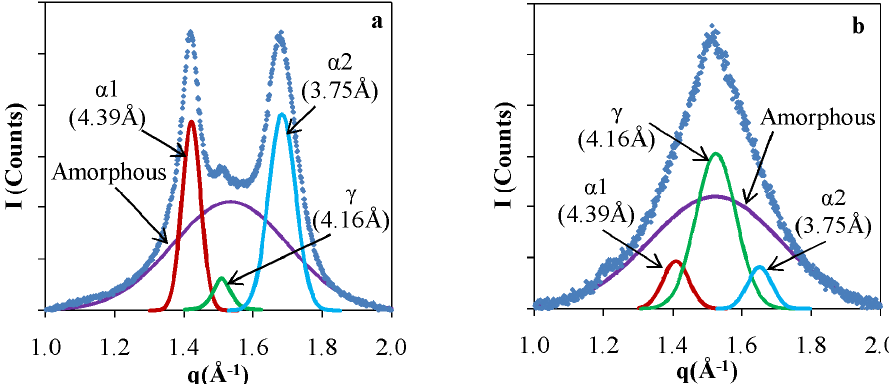
Figure 4. X-ray patterns and analysis of Poly Amide 6 (PA6) films ( a ) Pristine; and ( b ) Chaotically blended at N =